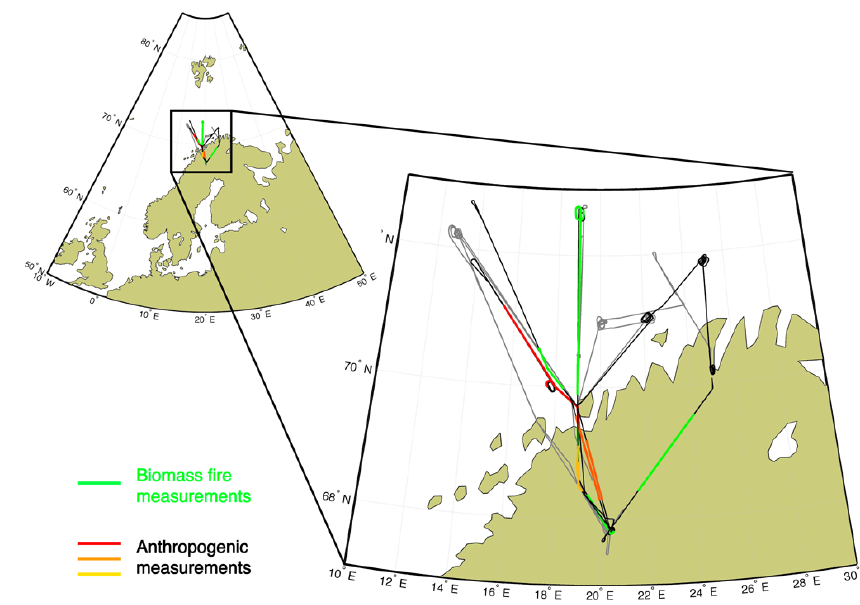
Fig. 1. ATR-42 flight tracks highlighting the legs on which forest fire and anthropogenic plumes were sampled.